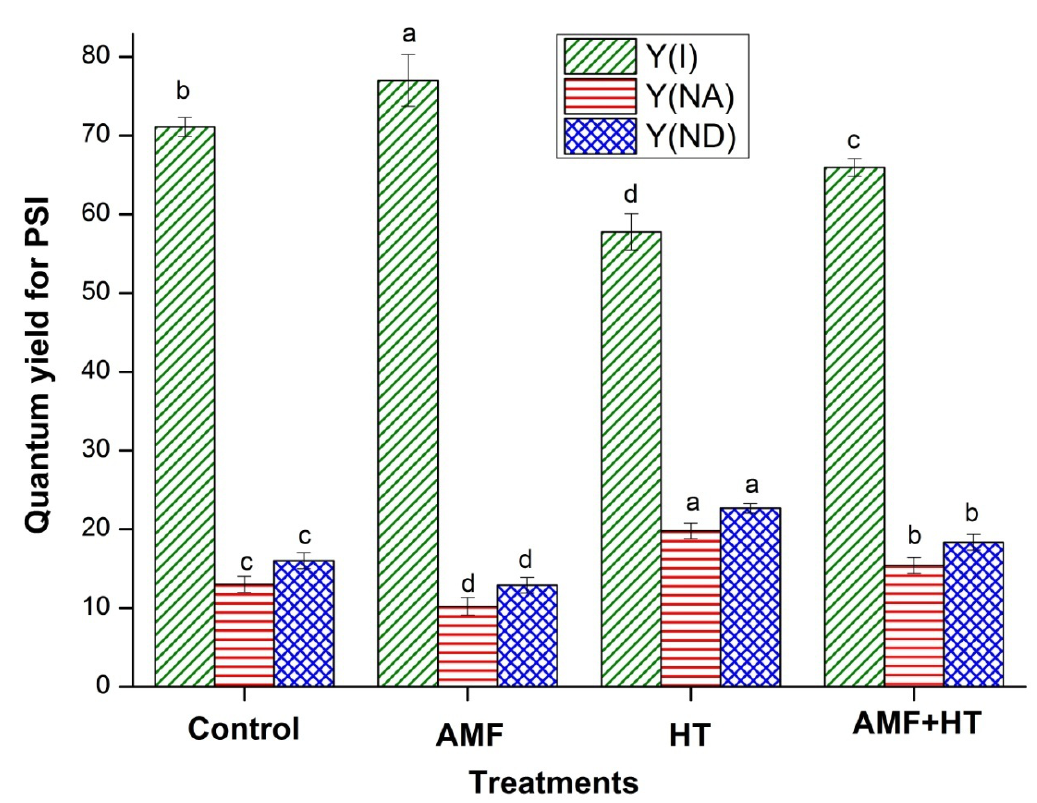
Figure 3. Quantum yields of energy conversion in PSI in control, AMF, high temperature (HT), AMF + HT maize leaves under high temperature, for Y(I) = quantum yield of PSI, Y(NA) = the quantum yield of non-photochemical energy dissipation caused by acceptor-side limitation, Y(ND) = is the quantum yield of non-photochemical energy dissipation caused by donor side limitation. The data are the mean values of three replicates ± standard deviation, treatment means followed with different letters vary significantly at p = 0.05 in compliance with Fisher least significant differences (LSD) and Duncan multiple range test (DMRT) for multiple comparisons. Table 3. The effect of high-temperature stress on PLFA communities (nanomoles g − 1 ) analyzed in maize rhizosphere.